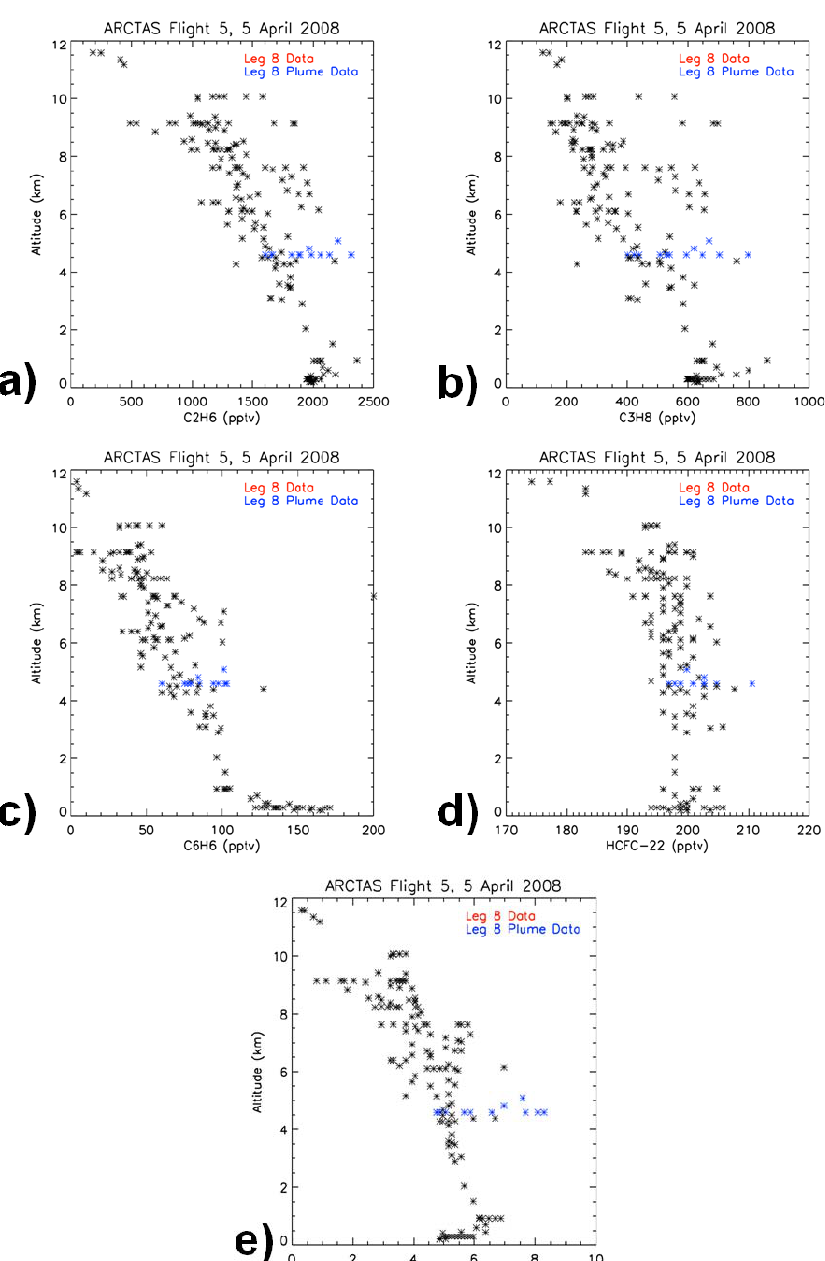
Fig. 10. Vertical distributions of data from flight 5 on 5 April 2008 for (a) C 2 H 6 , (b) C 3 H 8 , (c) C 6 H 6 , (d) HCFC-22, and (e) C 2 Cl 4 . Blue points are from leg 8, representing the sampled plume. In this case the plume is represented by all of the data points along leg 8. Black points represent the remaining legs of flight 5.